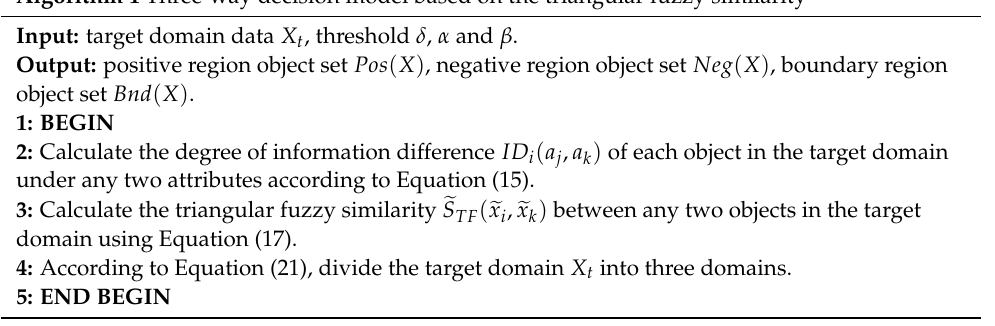
Algorithm 1 Three-way decision model based on the triangular fuzzy similarity